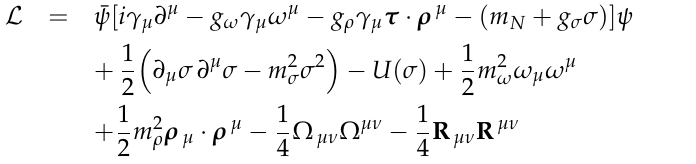
− 1 ], ) [fm 2 ], A ≡ a / g 3 / m 2 σ [fm i i